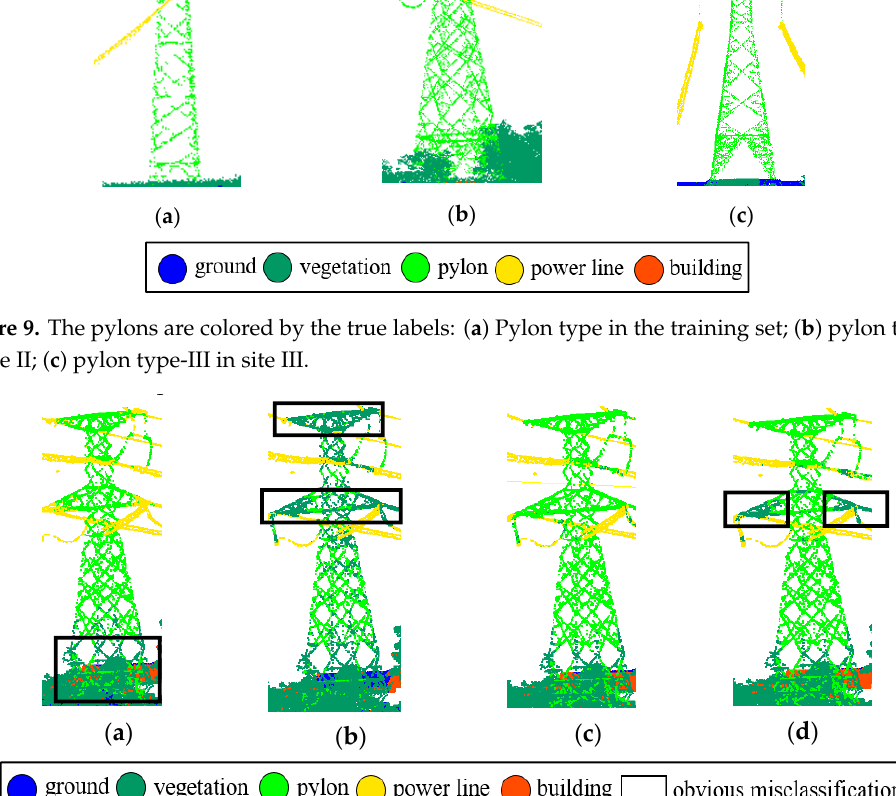
Figure 9. The pylons are colored by the true labels: ( a ) Pylon type in the training set; ( b ) pylon type-I in site II; ( c ) pylon type-III in site III.